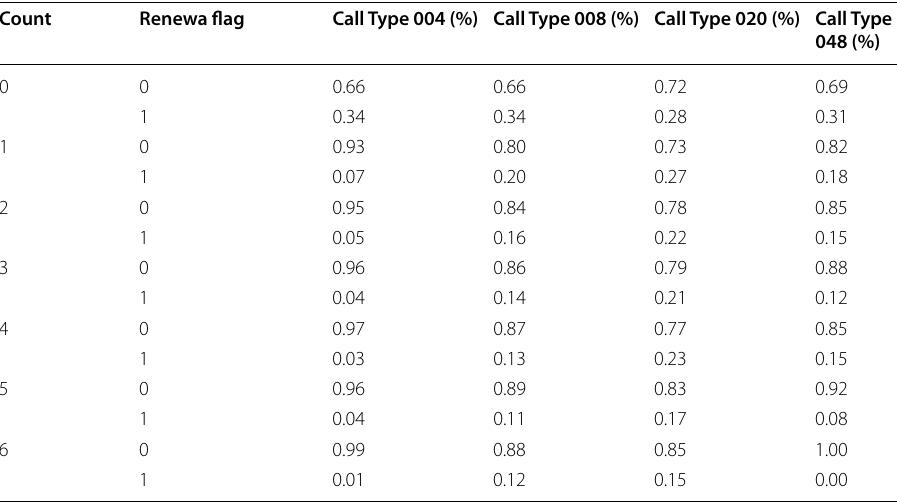
Table 4 Results of comparative analysis by renewal (Y/N) – call type features